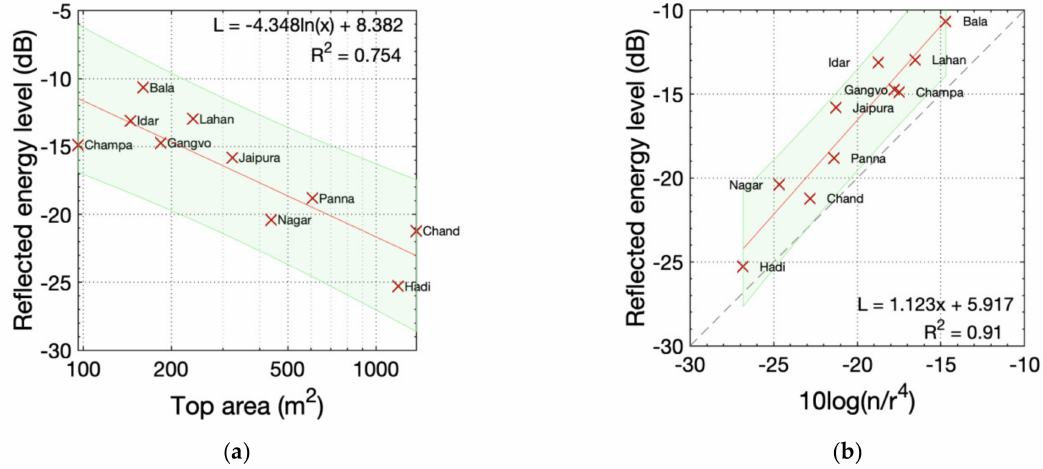
Figure A2. Estimated reflected energy level (1–4 kHz octave band mean, calculated as described in this appendix) from retroreflection in relation to the top area of the 10 stepped ponds from Table 1: ( a ) calculated values in relation to the top area of the stepped pond; ( b ) calculated values in relation (cid:16) (cid:17) n / ( r ) 4 to 10log for visible reflectors. Regression lines and 95% confidence intervals are